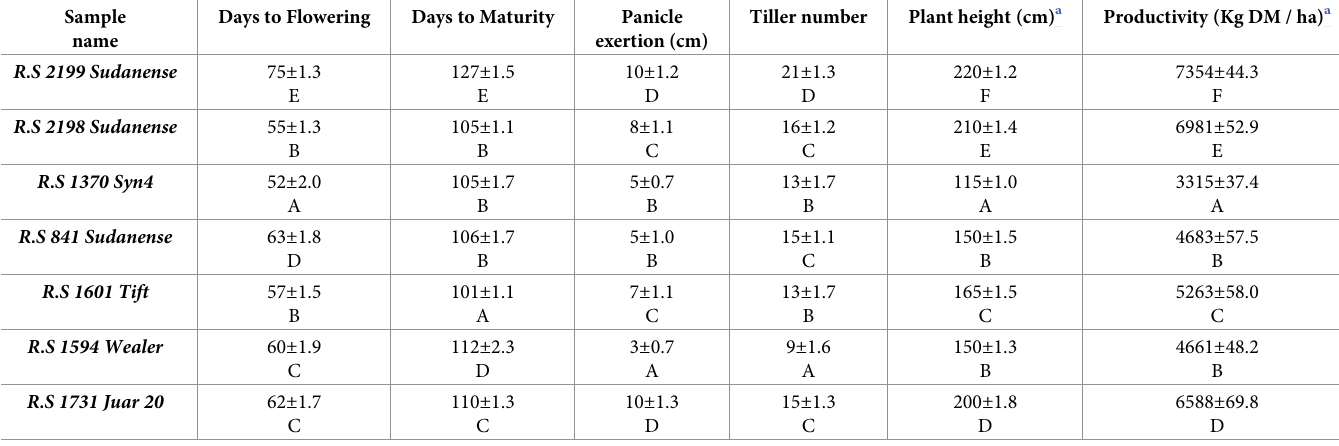
Table 1. Phenological traits across sudangrass